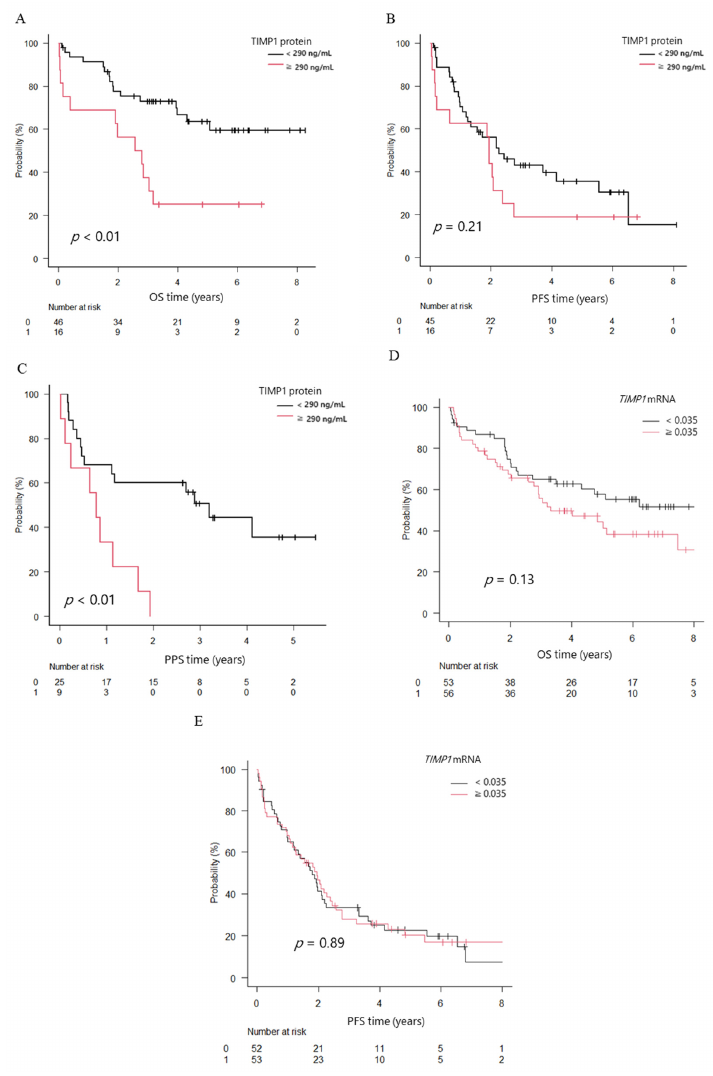
Figure 4. Overall survival (OS), progression-free survival (PFS), and post-progression survival (PPS) in patients with newly diagnosed multiple myeloma (NDMM) divided into two groups. ( A ) OS. ( B ) PFS. ( C ) PPS. Black line, TIMP1 protein levels in bone marrow plasma <290 ng/mL; red line, TIMP1 protein levels ≥ 290 ng/mL. ( D ) OS. ( E ) PFS. Black line, TIMP1 mRNA levels in bone marrow myeloma cells <0.035; red line, TIMP1 mRNA levels ≥ 0.035.